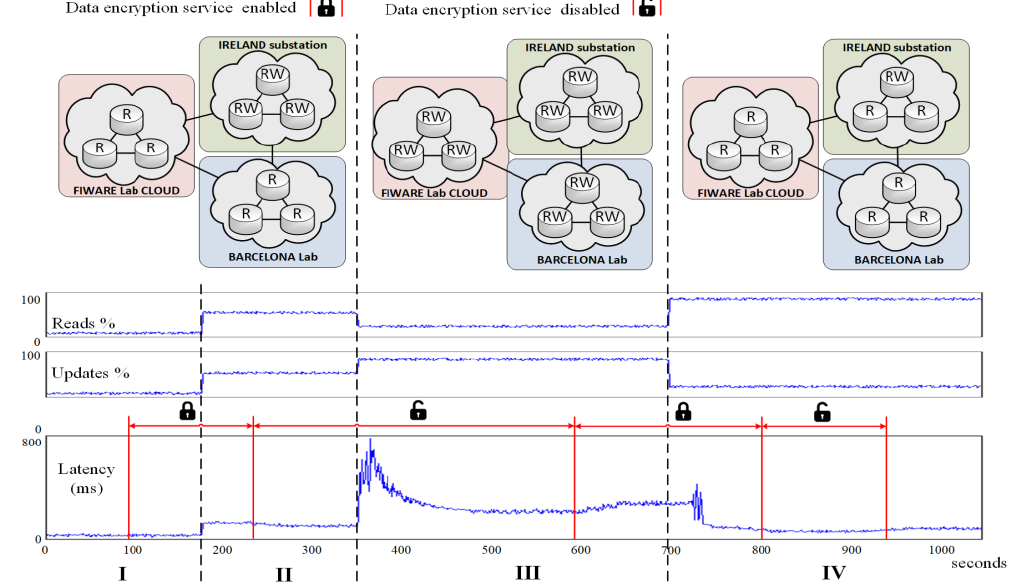
Figure 5. Evolution of the FIDEVs when exposed to different situations. Ratio of data requests (reads %), data generation (updates %), and overall latency from all the nodes are depicted on the bottom. FIDEVs configurations are depicted on top.